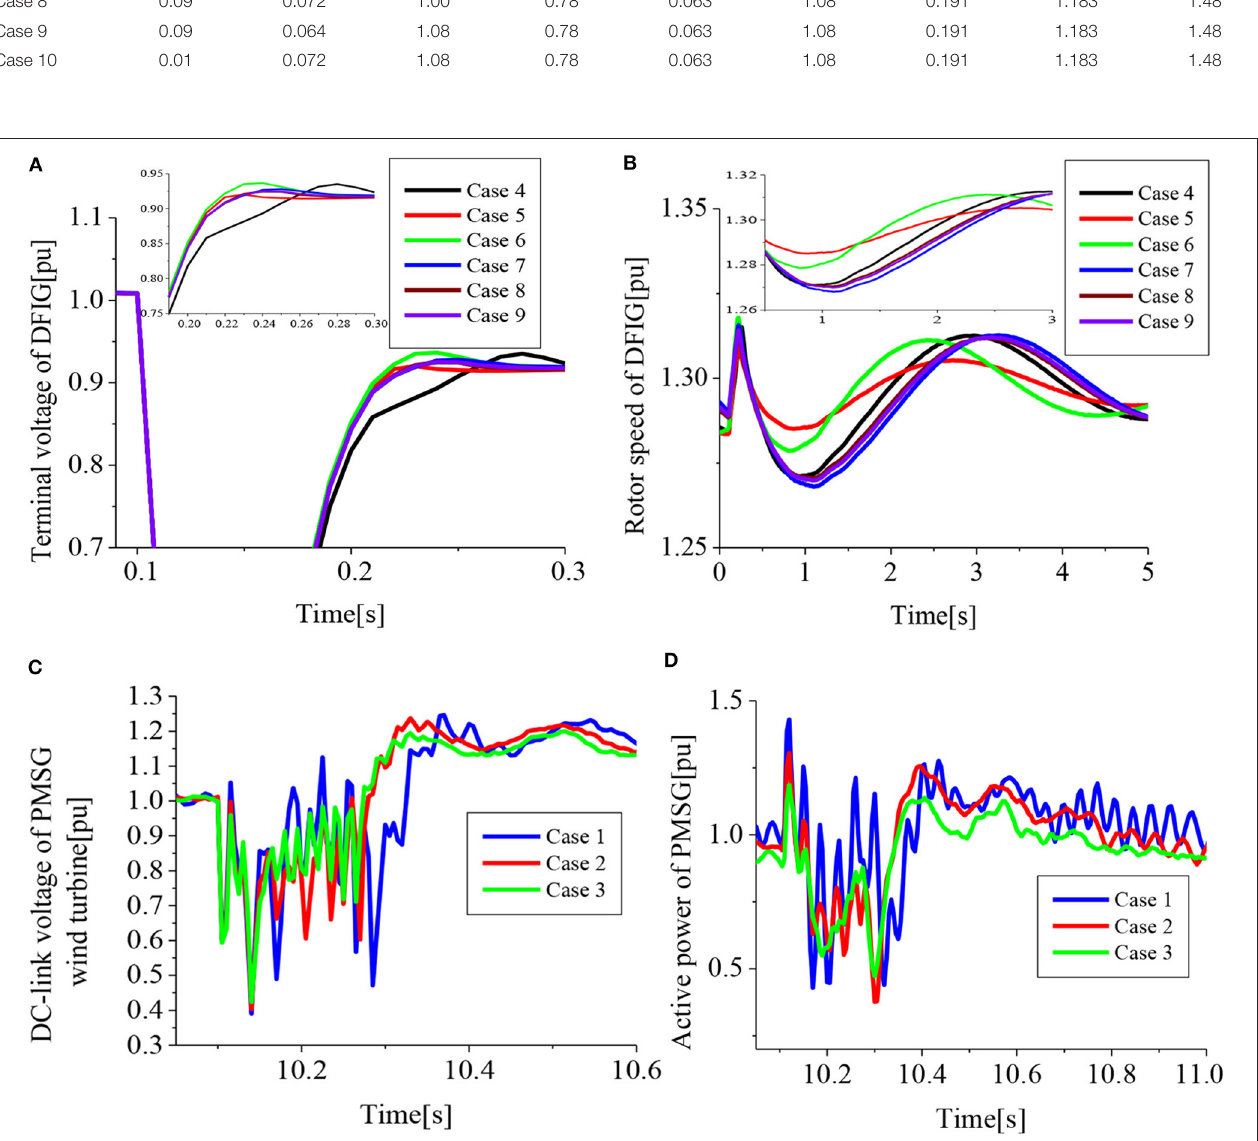
FIGURE 15 | (A) Terminal voltage of DFIG (cases 4–9). (B) Rotor speed of DFIG (cases 4-9). (C) DC-link voltage of PMSG (cases 1–3). (D) Active power of PMSG (cases 1–3).